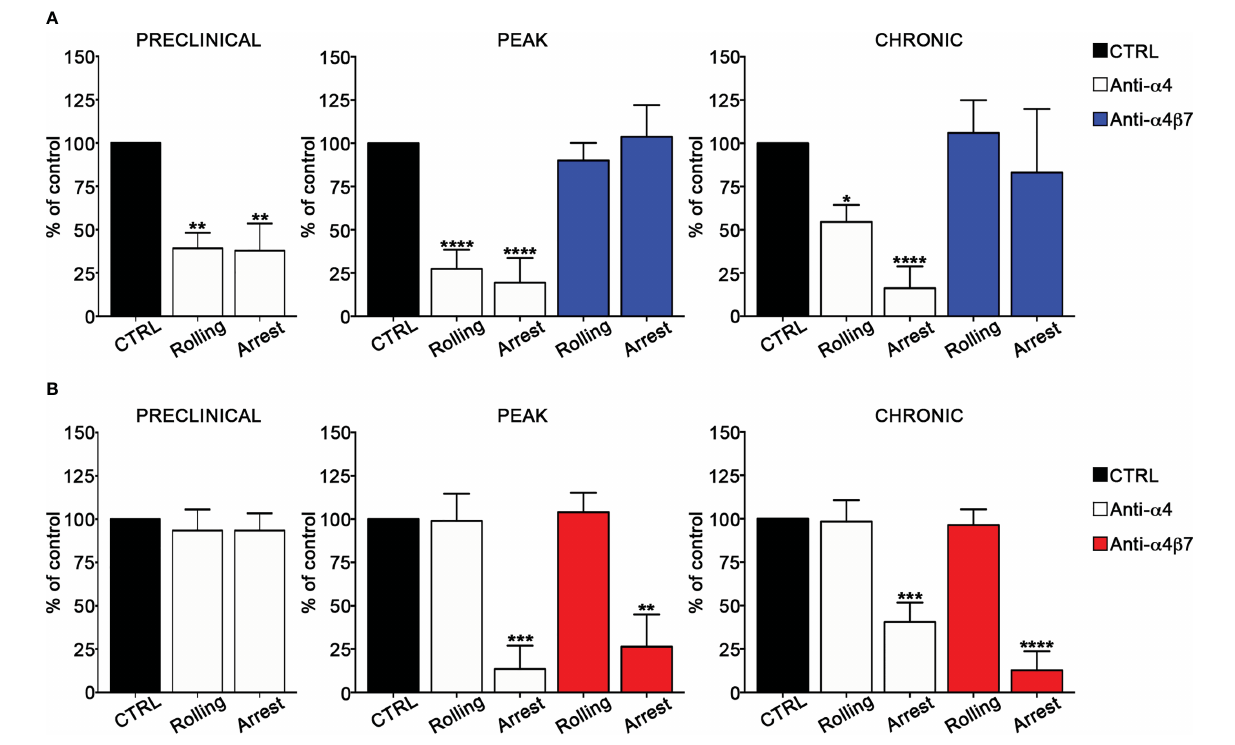
FIGURE 3 a 4 b 7 blockade selectively reduces Th17 cells arrest in the spinal cord pial vessels during EAE. In vitro differentiated Th1 or Th17 cells were fl uorescently labeled and sequentially injected in immunized mice in two tranches (untreated control cells and pretreated with the blocking antibody), EIVM imaging, conducted immediately after every single cell injection, was performed at the preclinical phase (9dpi), disease peak (13-15 dpi) and chronic phase (22-25 dpi) of EAE. (A) Rolling and arrest of Th1 cells before and after anti- a 4 or anti- a 4 b 7 antibodies treatment. (B) Rolling and arrest of Th17 cells before and after anti- a 4 or anti- a 4 b 7 treatment. Ordinary one-way ANOVA followed by Dunnett ’ s multiple comparison test was applied comparing the frequency of rolling and adhesion events after antibody treatment with control (considered 100%). Data are represented as mean ± SEM from a minimum of 12 to a maximum of 24 venules from three independent experiments for each condition. (* P < 0.05, ** P < 0.01; *** P < 0.001, **** P <